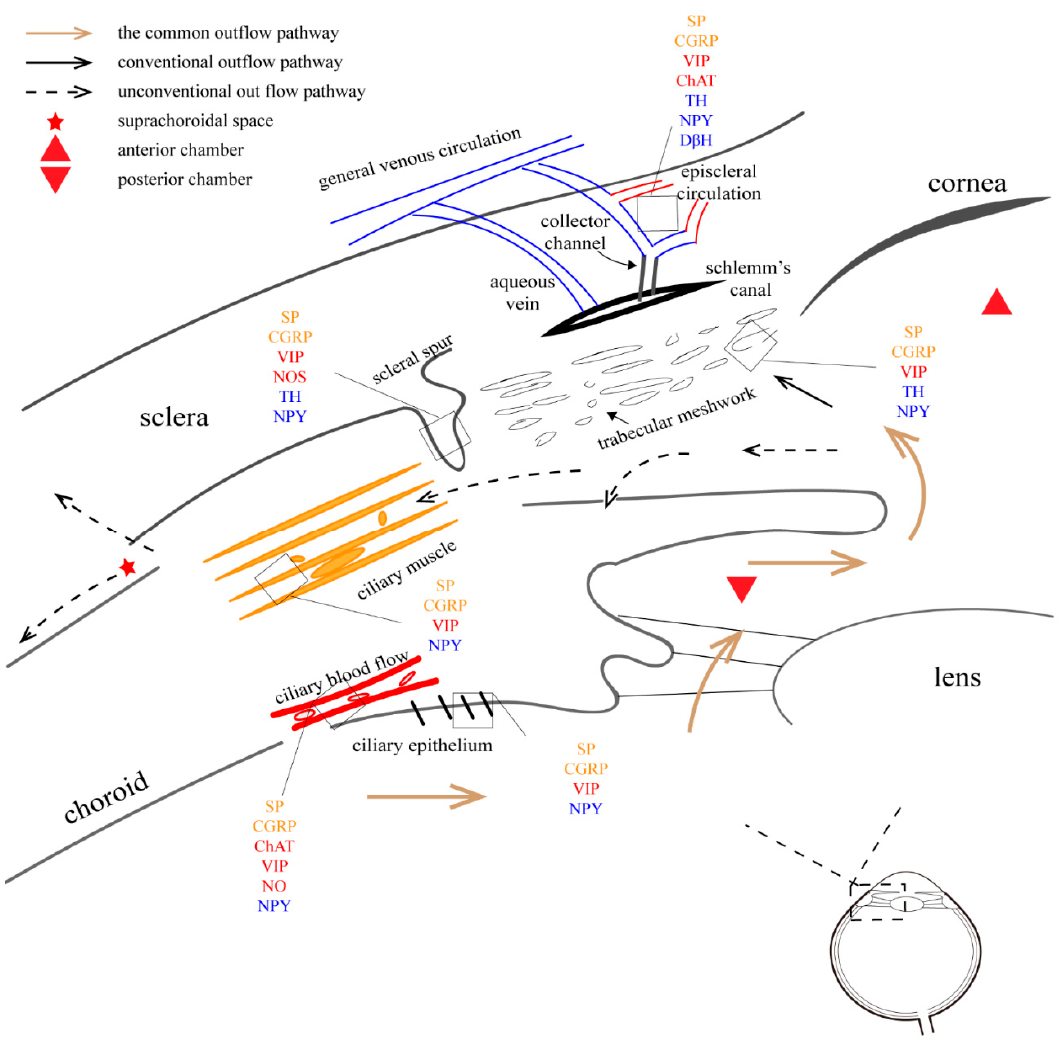
Figure 3. The aqueous humor outflow pathway. The red words represent parasympathetic innervation, the blue words represent sympathetic innervation, and the yellow words represent trigeminal innervation, respectively. There are two pathways of AH outflow: (1) conventional outflow pathway: non-pigmented epithelial cells → posterior chamber → anterior chamber → TM → Schlemm canal → collection tube, aqueous vein → episcleral vasculature → general venous circulation; (2) unconventional outflow pathway: non-pigmented epithelial cells → posterior chamber → anterior chamber → ciliary body clefts → interstitial spaces of the ciliary muscle → suprachoroidal space, vortex veins, and sclera. The uveolymphatic pathway remains controversial.